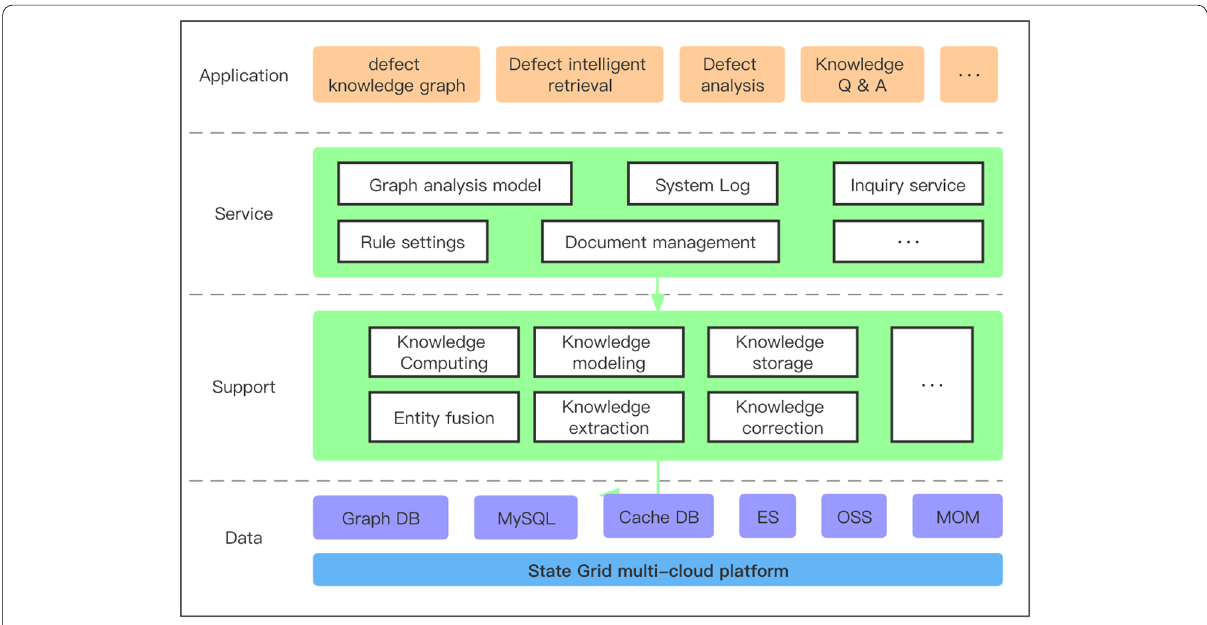
Fig. 2 System architecture of power equipment defect